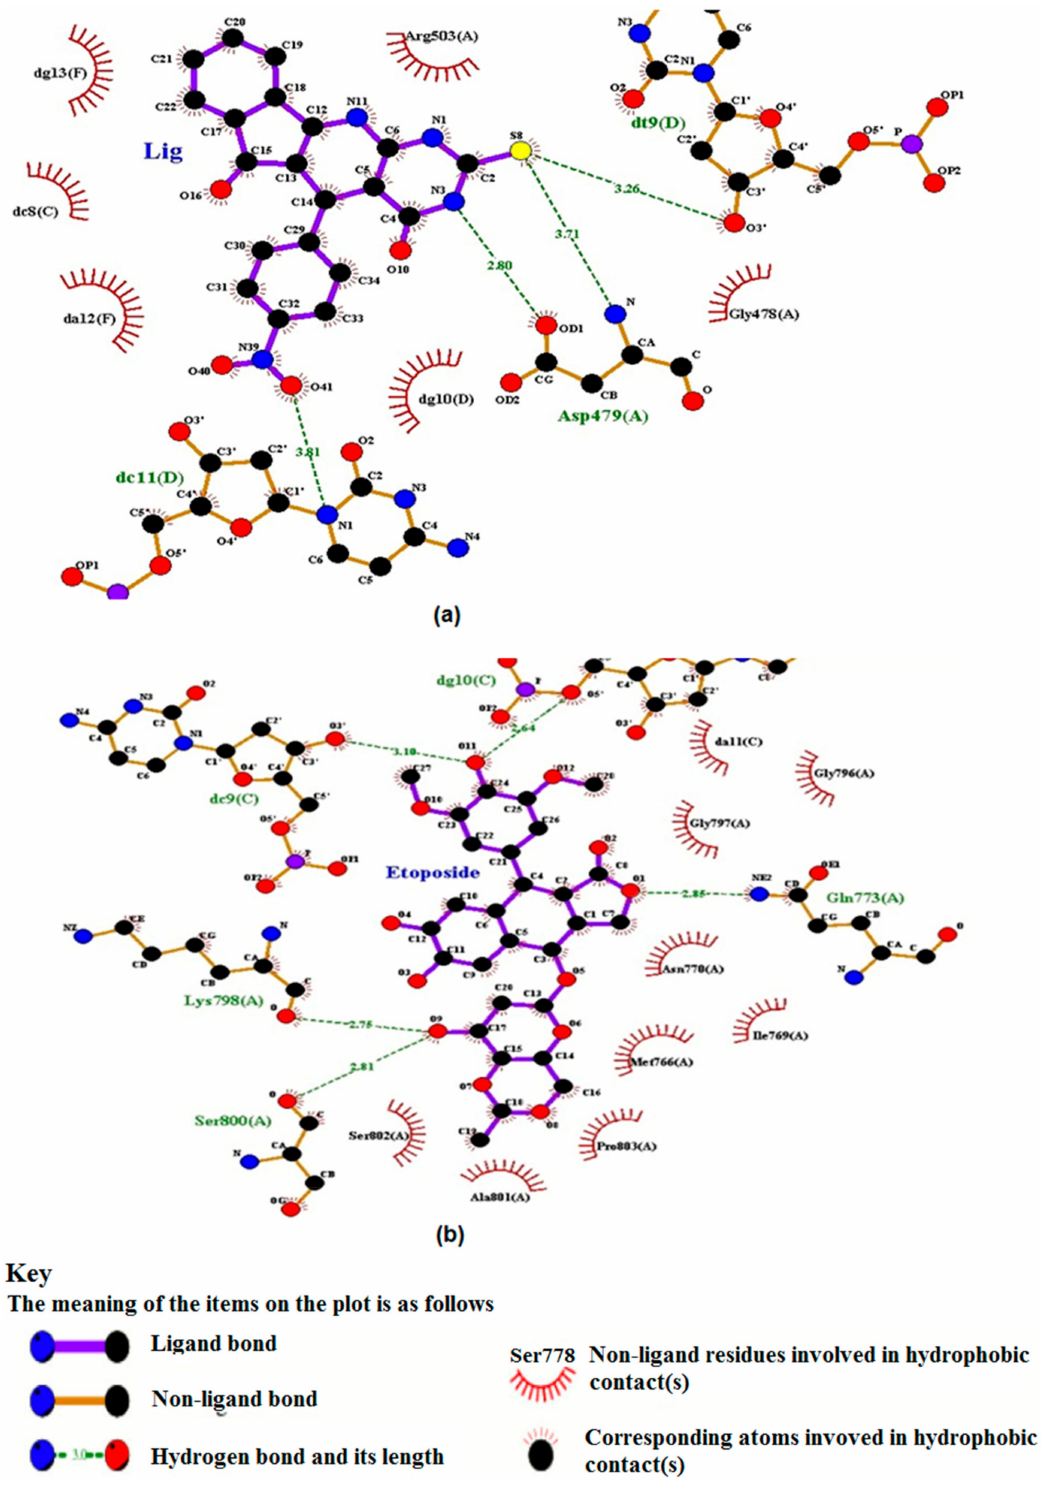
Figure 8. ( a , b ) Two-dimensional binding sites scheme of 6H and Etoposide respectively with human DNA topoisomerase II β ,